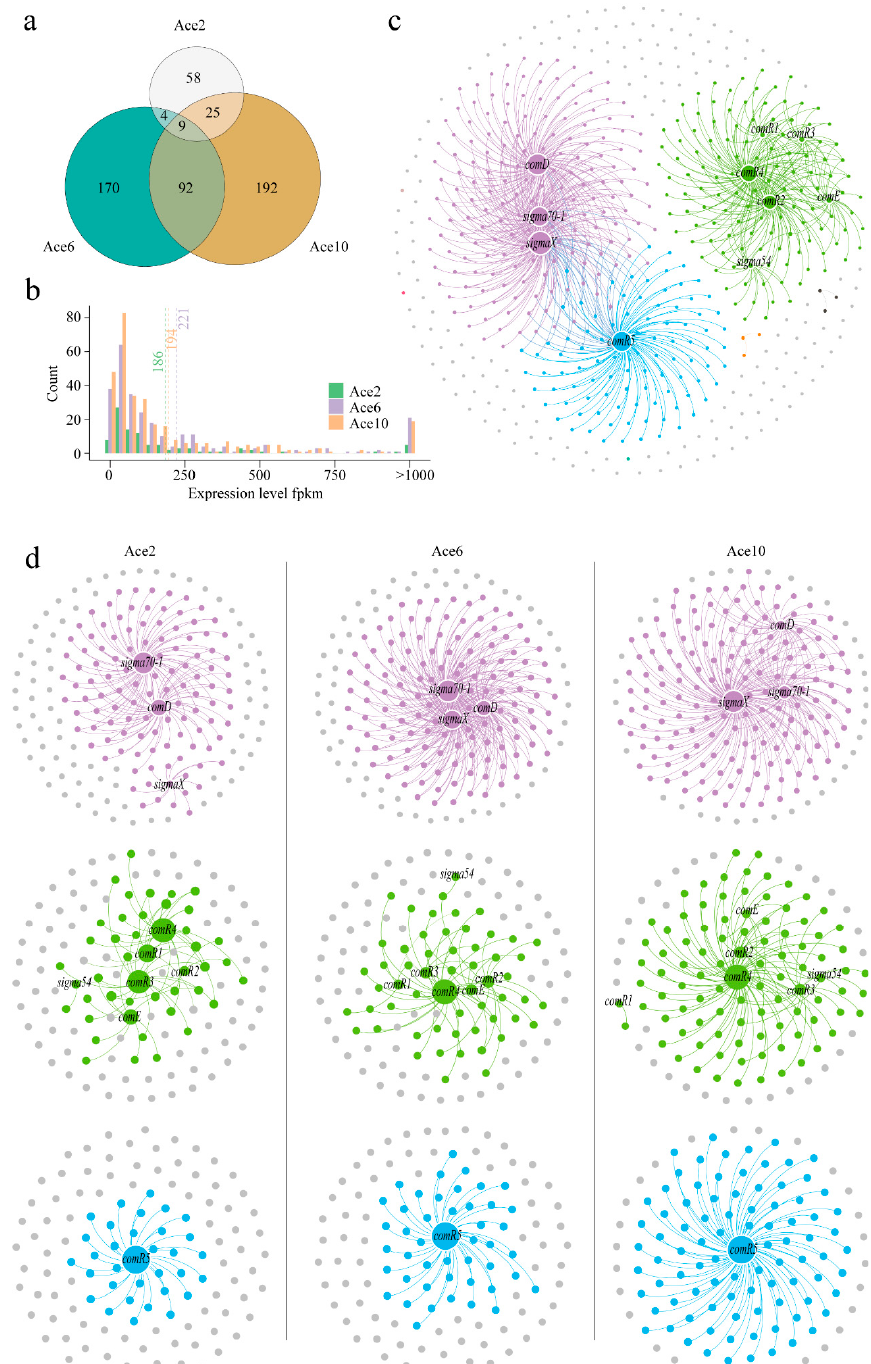
Figure 3. Transcriptional profiling of L. paracasei HD1.7 in response to high acetic acid stress. ( a ) Venn diagram showing the number of differentially expressed genes under acetic acid stress (|Log 2 FC| > 1.5, p < 0.05); ( b ) histogram of differentially expressed genes; ( c , d ) co-occurrence network analysis of genes in the bacteriocin regulatory system under acetic acid stress to explore associations between gene expression (|r| > 0.8; p < 0.05). Each dot represents a gene. ( c ) Represents overall collinear network analysis; ( d ) represents grouped collinear network analysis.